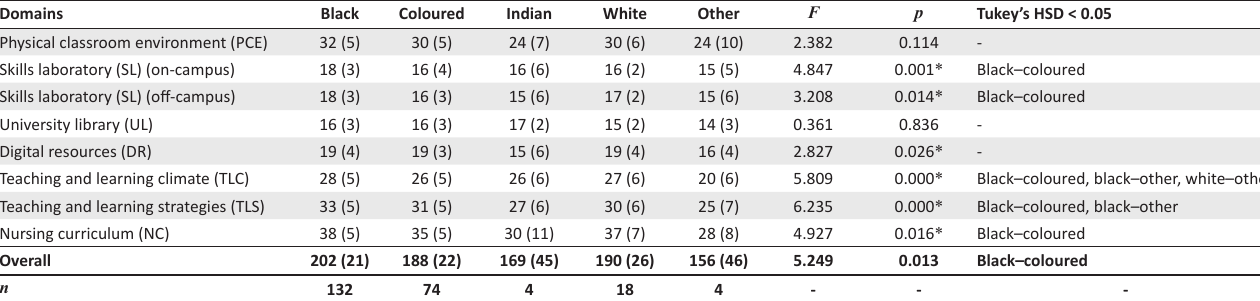
TABLE 3: Mean (standard deviation) and overall score by ethnicity. Domains Black